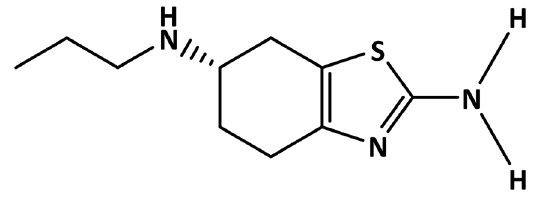
Figure 1. Molecular structure of PMXL.